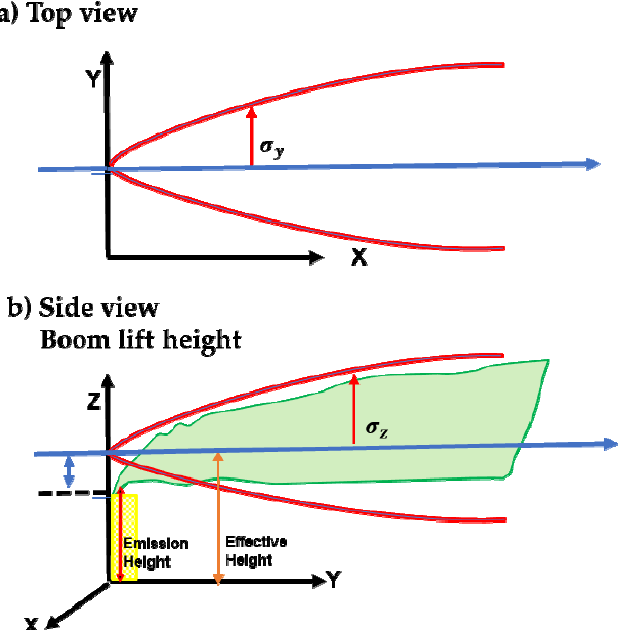
Figure 4. Dispersion coefficients. ( a ) Top view of dispersion σ y , ( b ) dispersion z exe, σ z . Source: own elaboration and adapted from the two-dimensional Gaussian model [29].